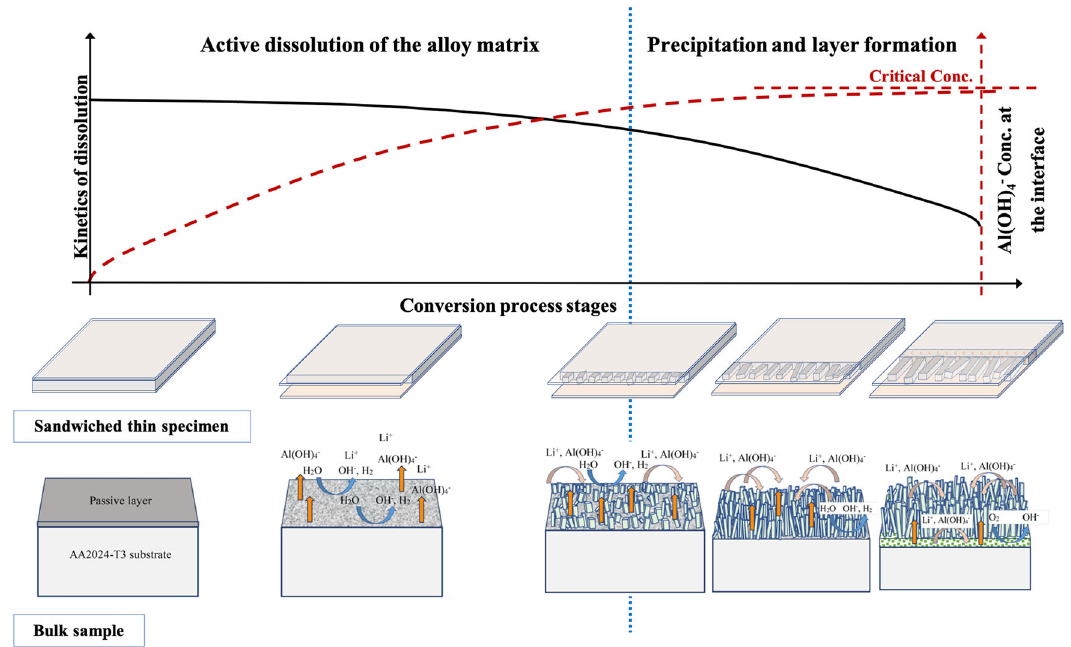
Fig. 8 Morphological stages of the lithium-based conversion layer formation. The graph schematically shows the change of the Al(OH) 4 − concentration and the dissolution kinetics while the conversion layer morphologically evolves. The pictures schematically show different stages of the conversion layer formation in the sandwiched thin specimen corresponding to the bulk